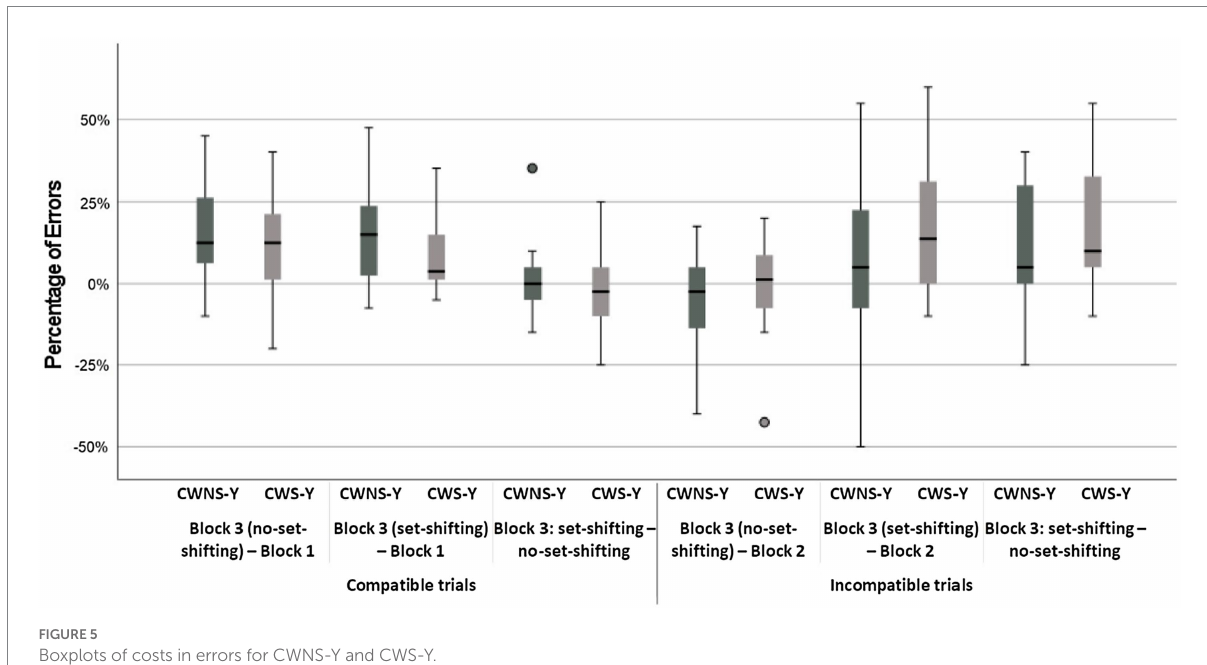
FIGURE 5 Boxplots of costs in errors for CWNS-Y and CWS-Y.